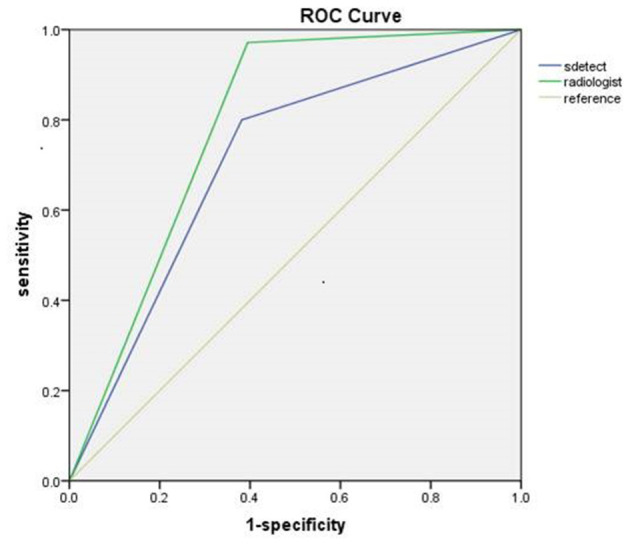
ROC curves of symptomatic patients.